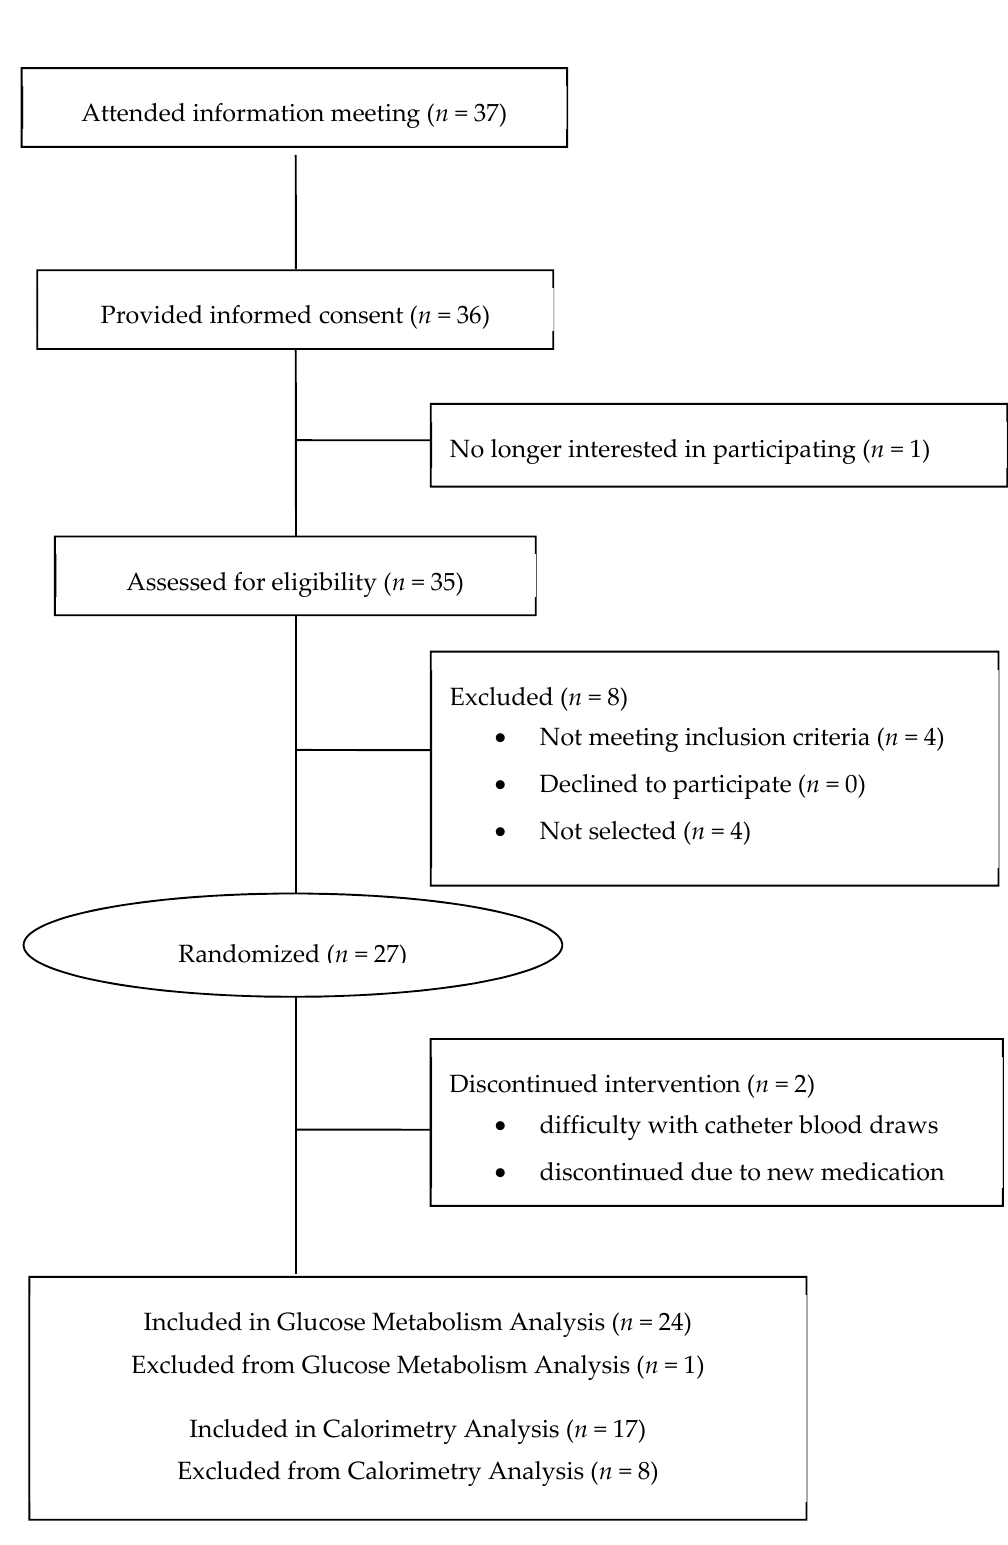
Figure 1. CONSORT (Consolidated Standards of Reporting Trials) diagram for the blackberry calorimetry study. One subject was excluded from the meal tolerance analysis for noncompliance. Eight subjects were excluded from the calorimetry dataset due to instrument failure during data collection.